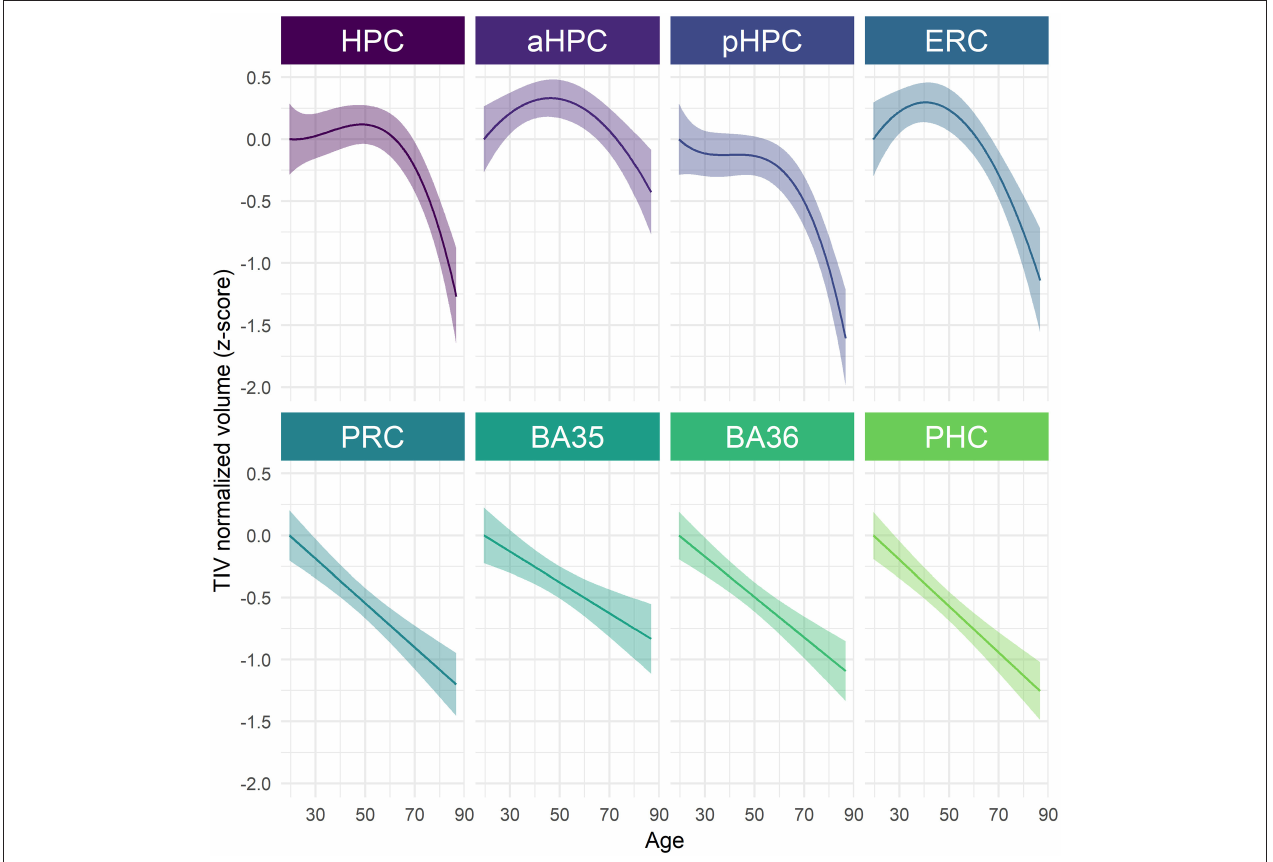
FIGURE 1 | Age-related volume trajectories of MTL subregions over the adult lifespan. All subregions were significantly related to age, p < 0.001. Continuous line indicates model-derived estimates. The shaded area represents a 95% confidence interval. BA, Brodmann area; ERC, entorhinal cortex; HPC, hippocampus (a, anterior; p, posterior); PHC, parahippocampal cortex; PRC, perirhinal